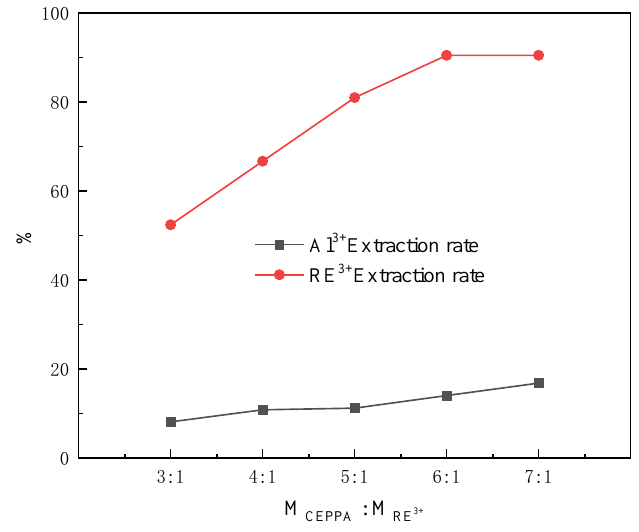
Figure 4. Effect of the CEPPA amount on the separation of rare earths and aluminum.